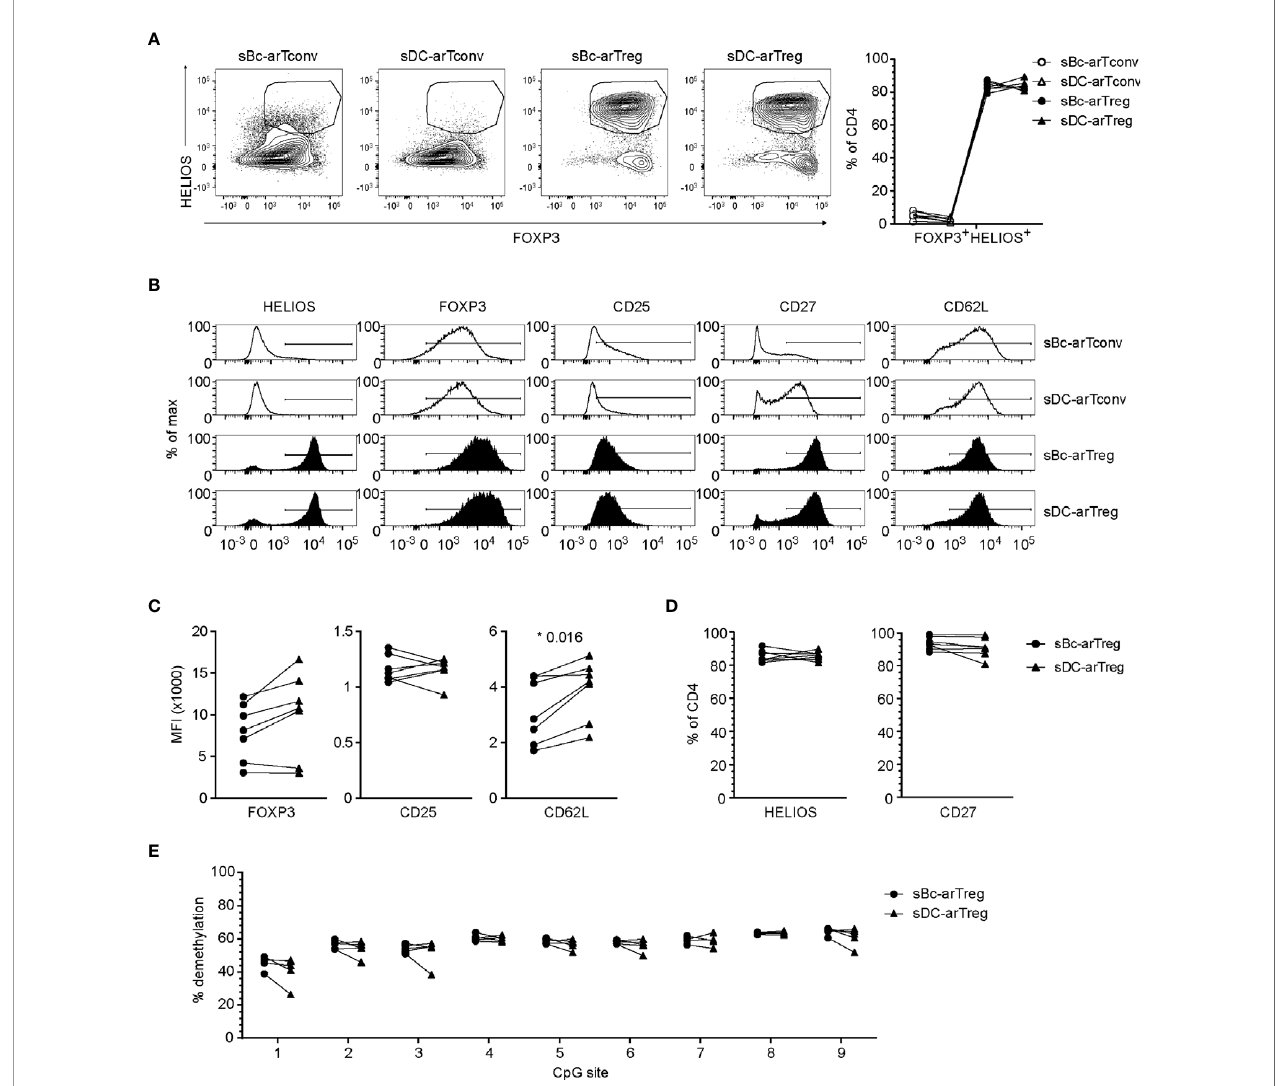
FIGURE 3 | sBc- and sDC-arTregs express Treg-associated molecules and are stable Tregs. (A – D) Expression of different molecules by arTregs and arTconvs was assessed by fl ow cytometry. (A) Representative FOXP3 versus HELIOS contour plots of arTregs and arTconvs (left) and %FOXP3 + HELIOS + of CD4 cells (right). (B) Representative histograms of arTregs and arTconvs. (C) Level of expression (MFI) and (D) Percentage of CD4 + T cells expressing speci fi c molecules. (E) Percentage of demethylated FOXP3 gene TSDR at different CpG sites. All arTregs were derived from female donors so maximum demethylation was ~50%. Data in (A – D) contain 7 different responder-stimulator combinations. Data in (E) contain 5 different responder-stimulator combinations. Connecting lines indicate alloreactive T cells stimulated by APCs (sBcs or sDCs) derived from the same donor. Statistics were performed between sBc-arTregs and sDC-arTregs using the Wilcoxon matched-pairs signed rank test. Data from arTconvs are shown as reference and were not included in statistical